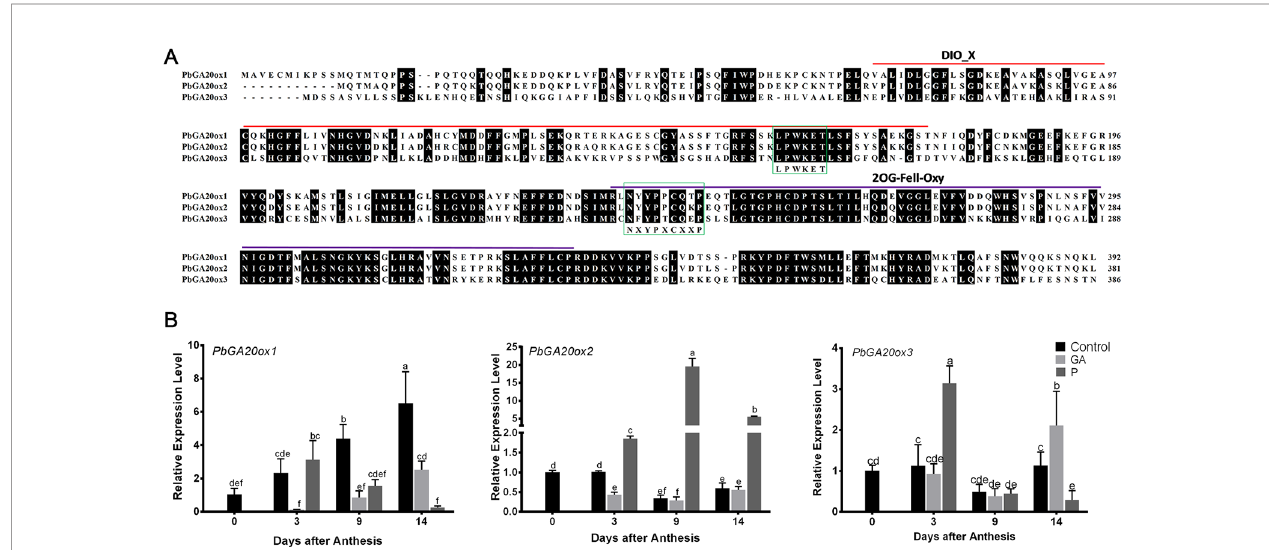
FIGURE 1 | Alignment of amino acid sequences of PbGA20ox s and their expression models after different treatments. (A) Alignment of the three amino acid sequences. DIO_X and 2OG-Fell-Oxy domains are marked with bold lines, and identical residues are shaded in black. The proposed conserved sequences ‘ NXYPXCXXP ’ and ‘ LPWKET ’ are indicated by green boxes. (B) Relative expression levels of PbGA20ox genes. Relative transcript quantities were determined by qRT-PCR. The expression level of each gene in fruits under control conditions at 0 DAT was normalized to 1.0. The results shown are means ± SD ( n = 3). Different letters between bars indicate signi fi cant differences at P < 0.05 (Duncan's range test). Control, nonpollinated; GA, gibberellin treatment; HP, hand